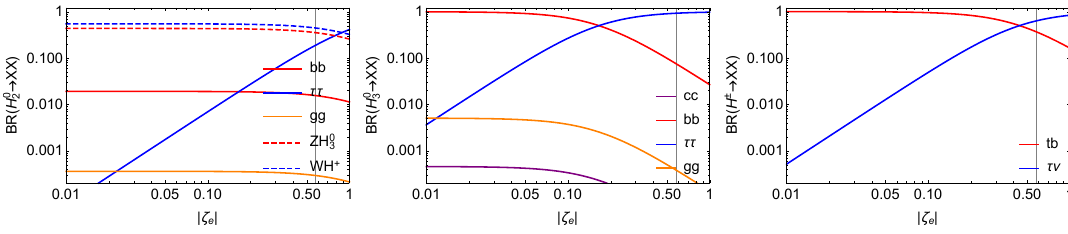
= m H = m H . H (cid:6) 2 3